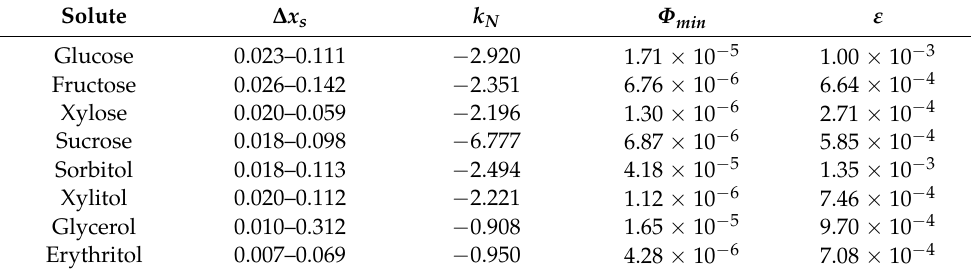
Table 1. Estimated Norrish constant values ( ∆ x s : experimental range of solute mole fractions; k N : Norrish constant; Φ min : minimum value of the objective function; ε : mean absolute error). Solute ∆ x s k N Φ min ε Glucose